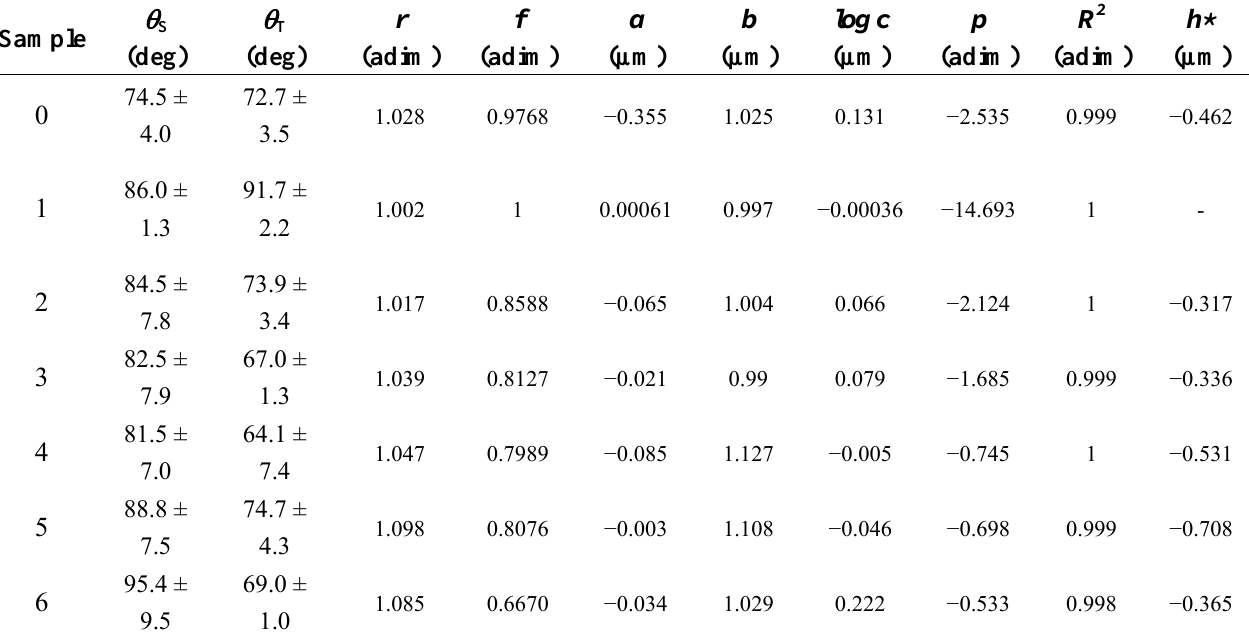
Table 2. Sigmoidal correlation constants and the calculated interfacial air height with respect to the mean height plane. Errors of contact angles are the standard